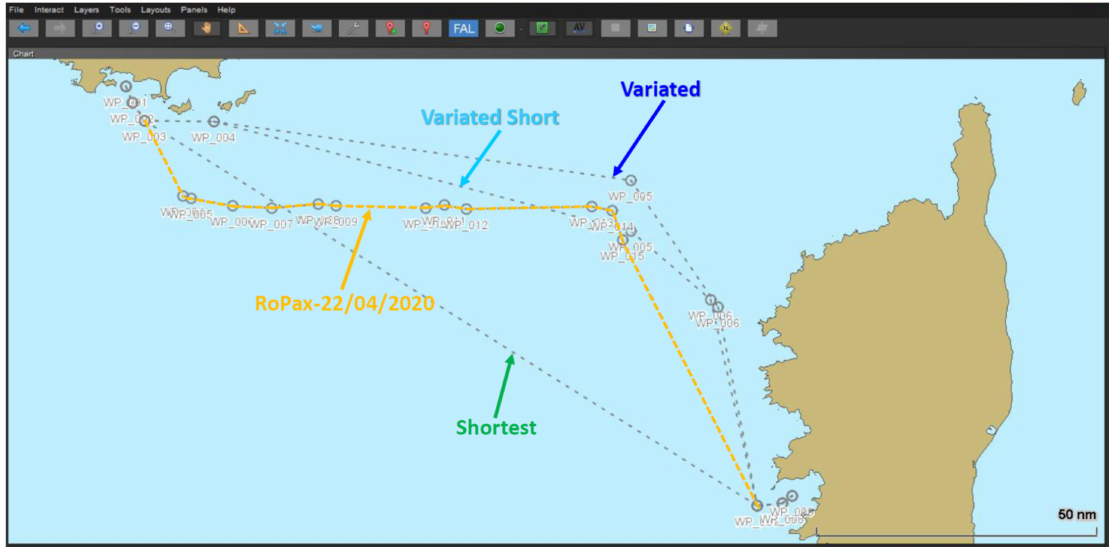
Figure 8. The route of Figure 7 labeled as “RoPax-22/04/2020” visualized through the prototype interface (evidenced in yellow), together with three variated routes labeled as “Shortest”, “Variated”, and “Variated Short”) generated by using the prototype interface